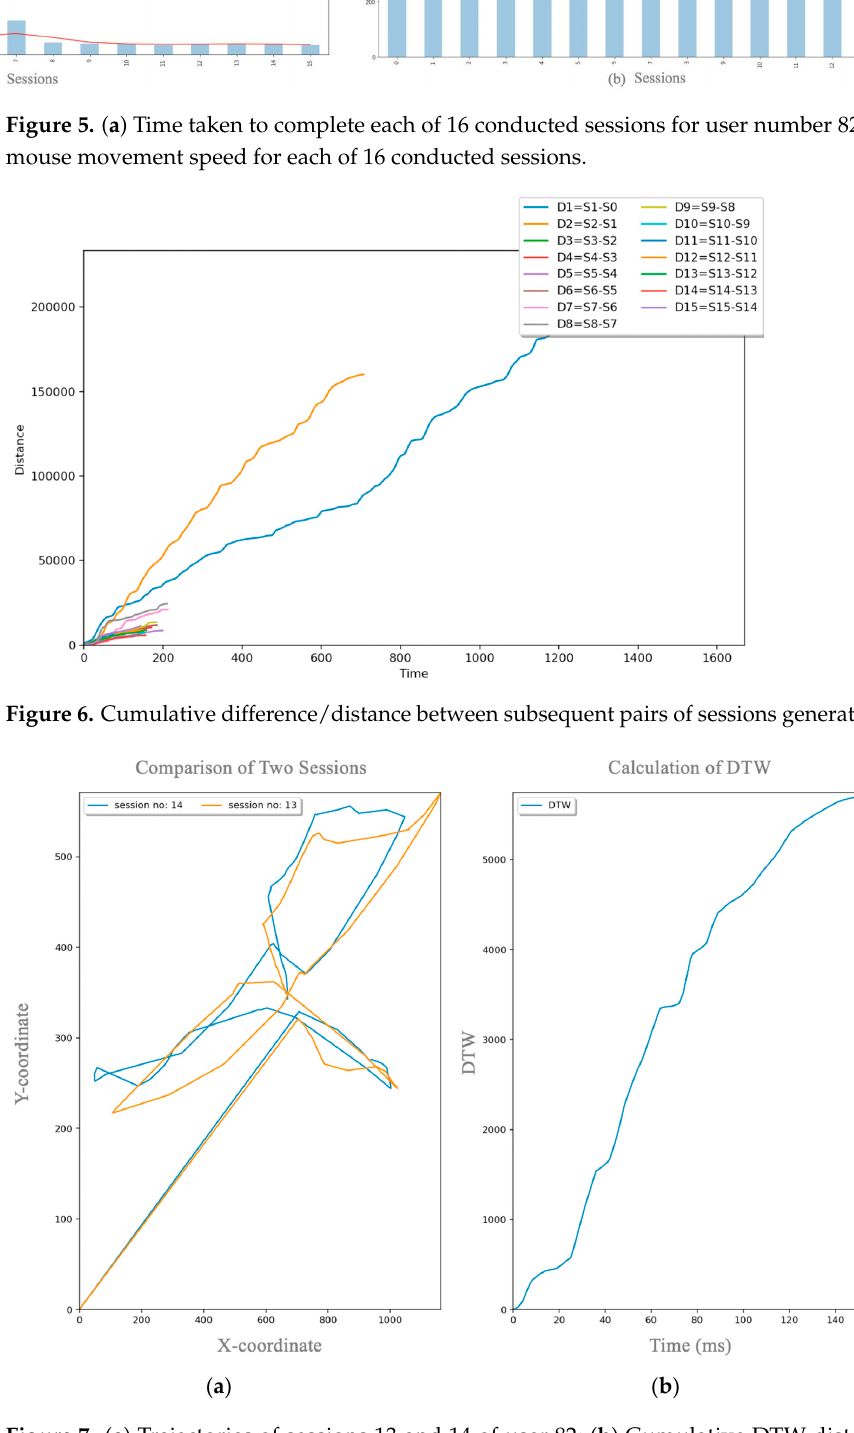
Figure 7. ( a ) Trajectories of sessions 13 and 14 of user 82; ( b ) Cumulative DTW distance between two sessions. two